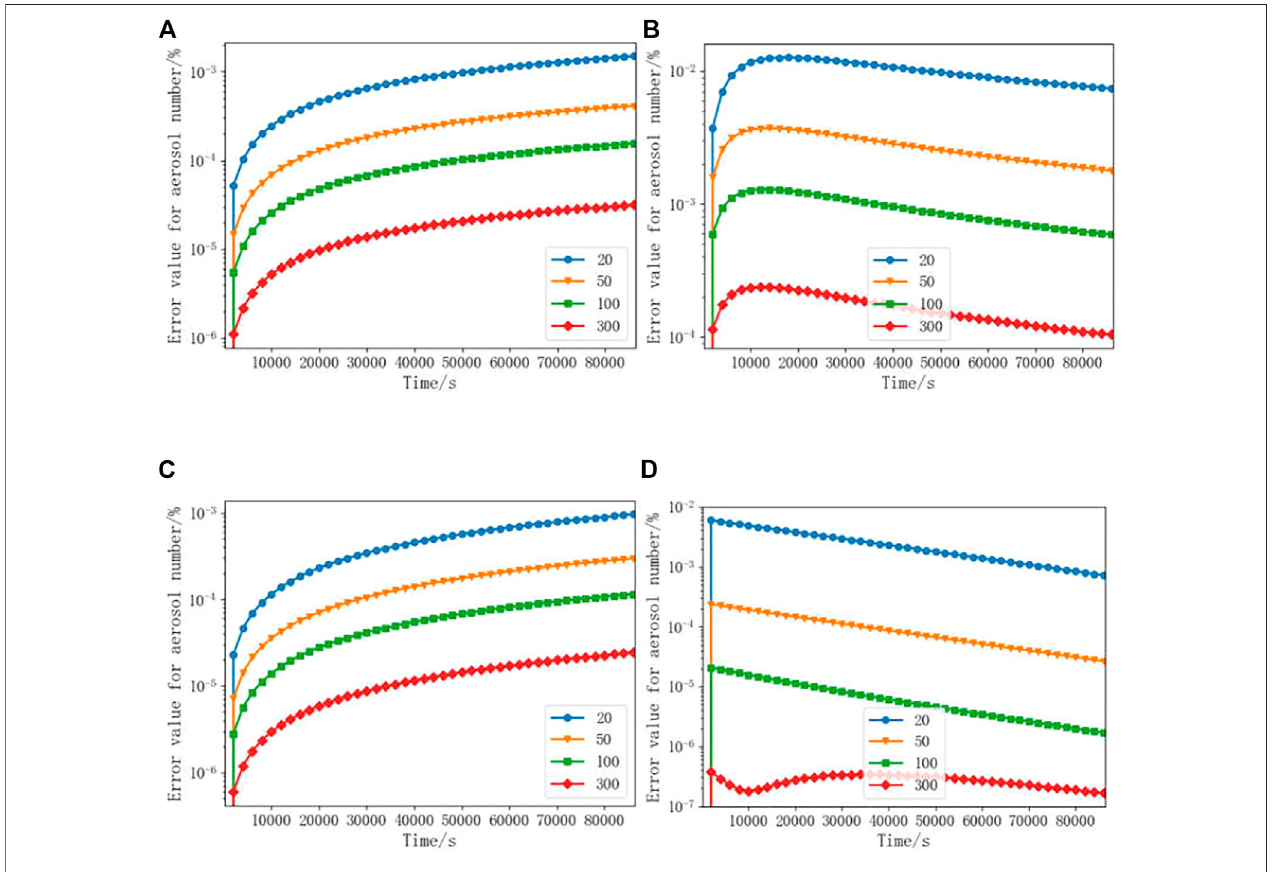
FIGURE 2 | Error value for the number of radioactive aerosols for the different sections. [ (A) , Constant coagulation kernel; (B) , linear coagulation kernel; (C) , constant coagulation kernel and the constant deposition rate of particles; and (D) , linear coagulation kernel and the constant deposition rate of particles].